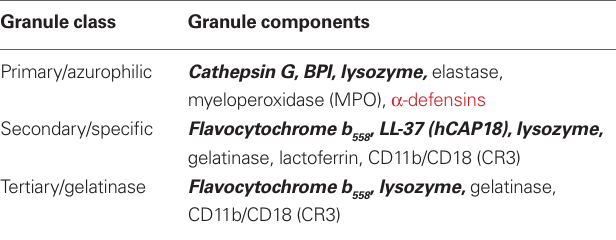
Table 1 | Antimicrobial components housed in PMN